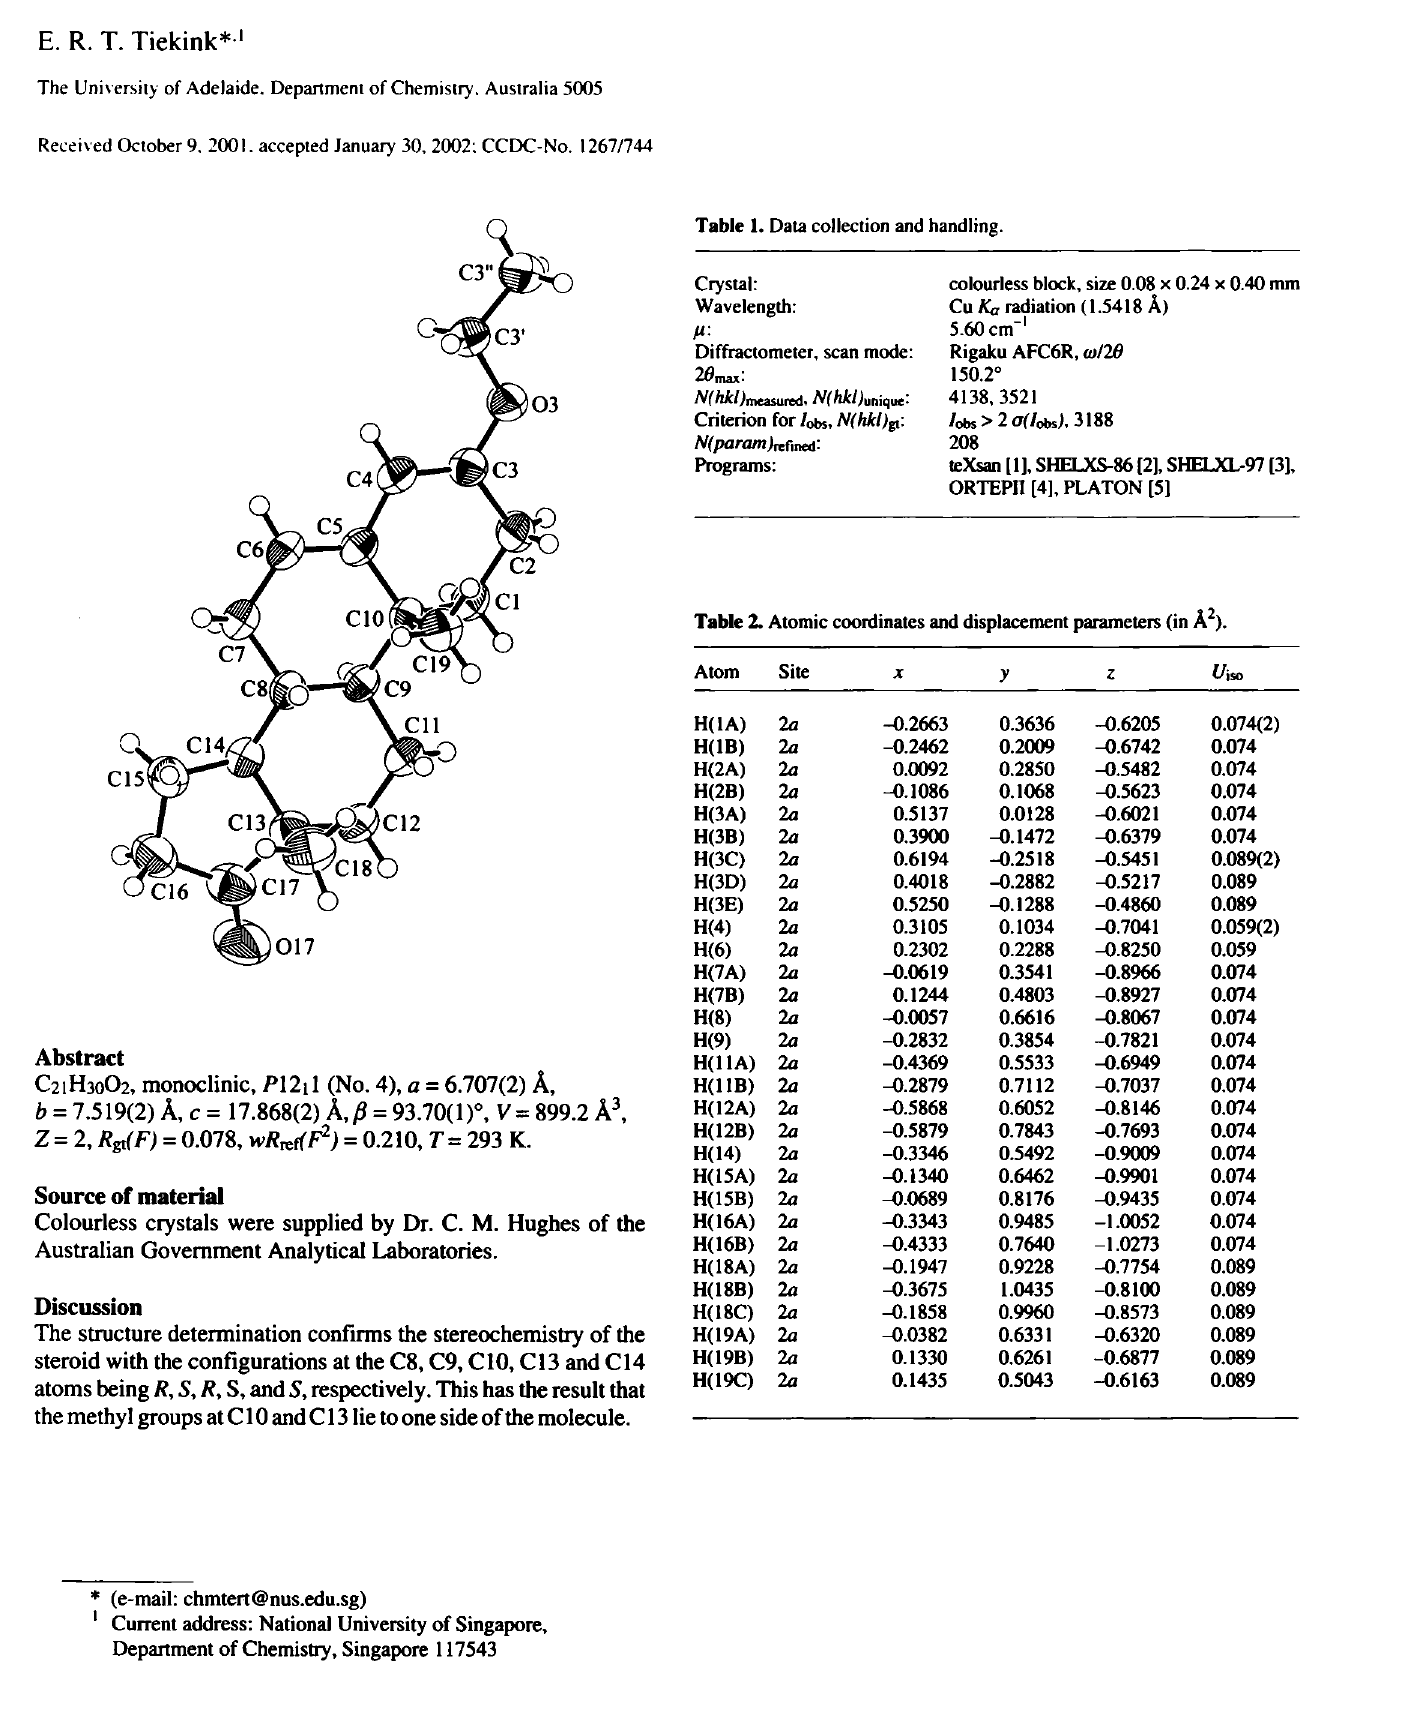
Table 2. Atomic coordinates and displacement parameters (in Â 2